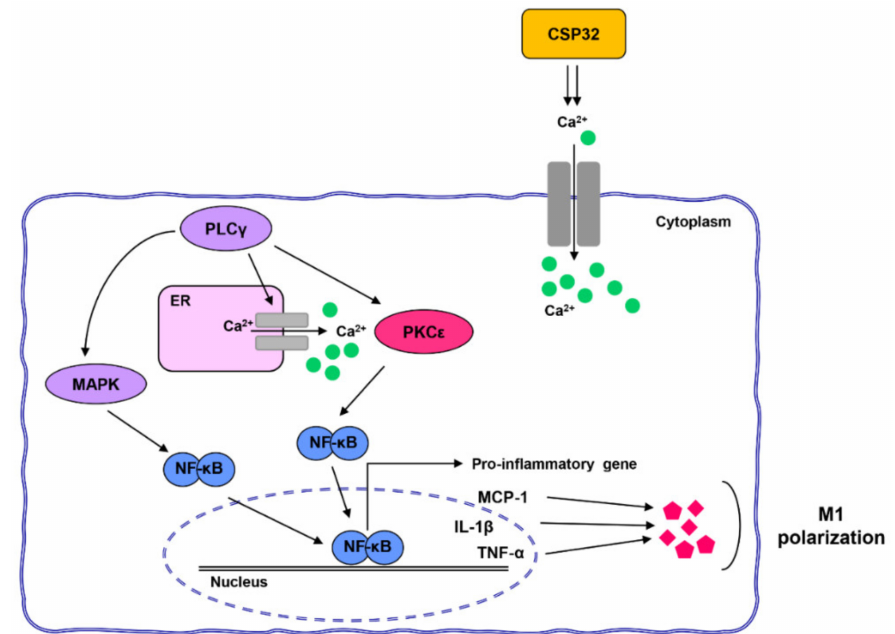
Figure 7. CSP32 stimulates M1 polarization via the calcium-dependent NF- κ B signaling